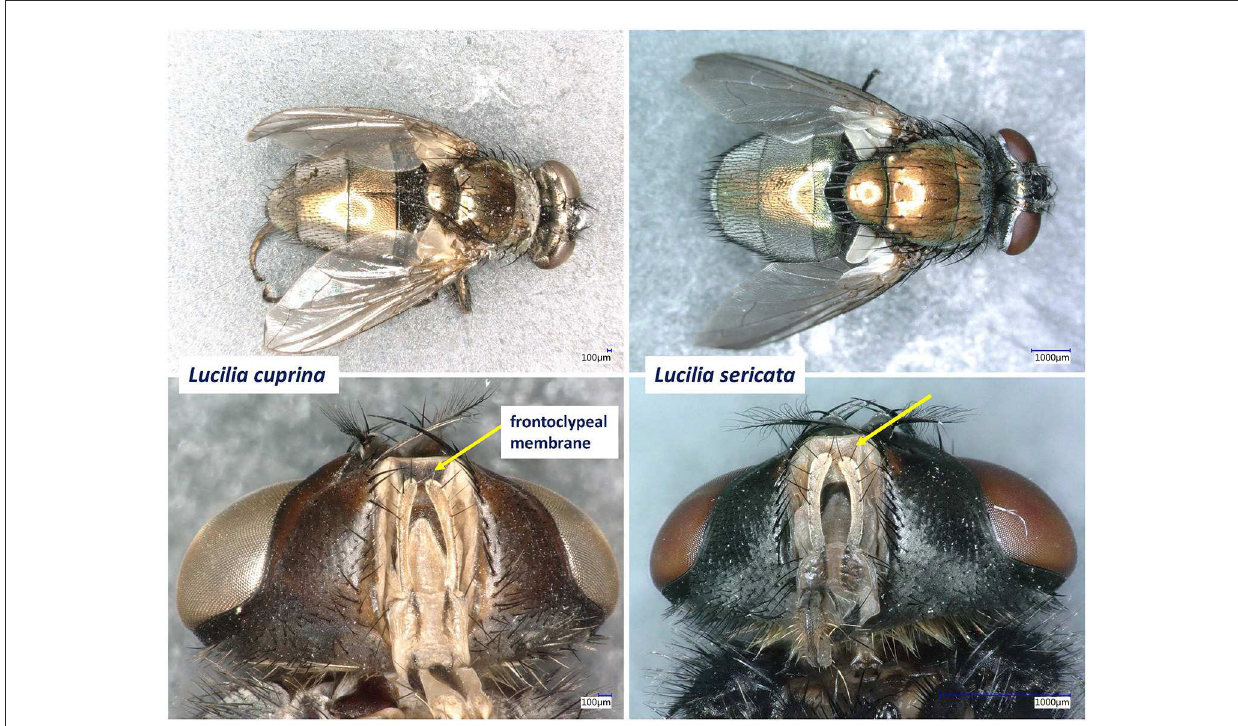
FIGURE2 Habitus and frontoclypeal membrane of Lucilia cupina sampled in Malta (Left) , in comparison with L. sericata (Right) . The yellow arrows indicate the frontoclypeal membrane.